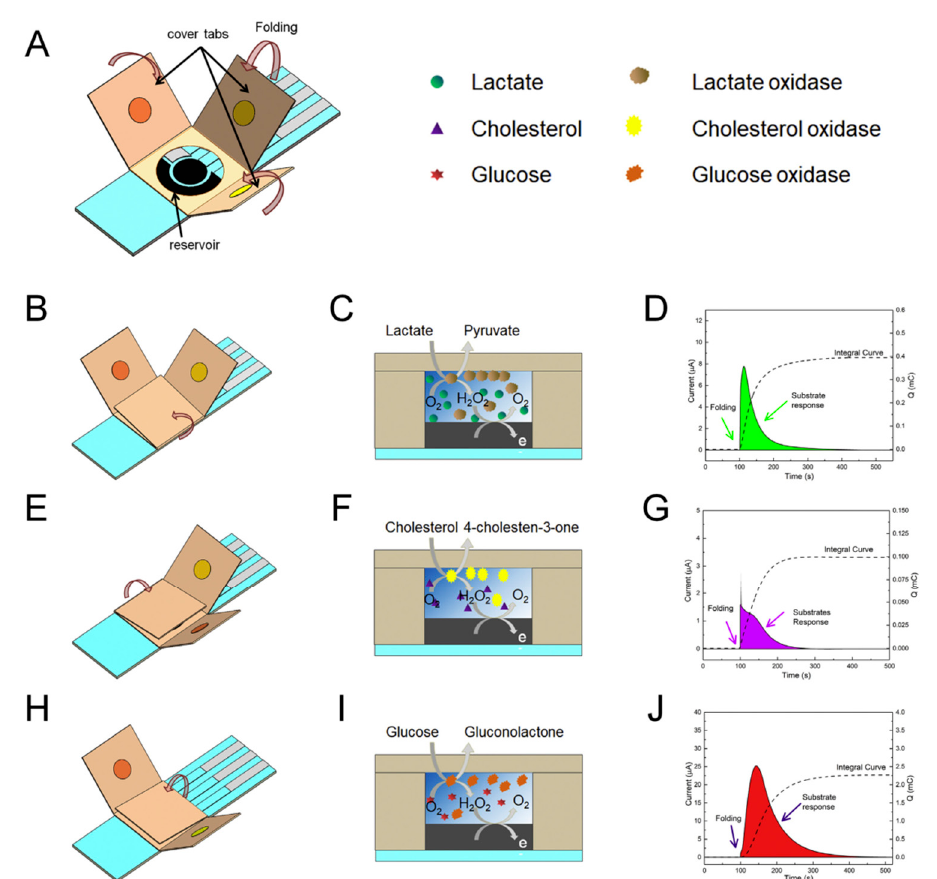
Figure 8. Scheme of the origami-based biosensor. ( A ): General structure of the origami based biosensor. ( B , E , H ): Folding scheme for the detection of lactate, cholesterol and glucose. ( C , F , I ): Schematic illustration of the transformations involved in the electrocatalytic determination of lactate, cholesterol and glucose. ( D , G , J ): The curves of current versus time (solid lines) and integrated charge over time recorded with the biosensor for the detection of lactate, cholesterol and glucose. Reproduced from [157] with